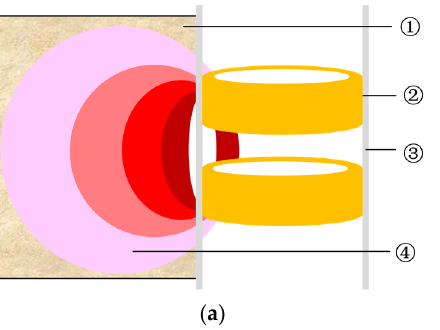
Figure 4. Structure and principle of high-frequency LC resonant capacitor probe. ( a ) Structural diagram; ( b ) circuit diagram. 1 (cid:13) Soil; 2 (cid:13) copper ring; 3 (cid:13) PVC pipe; 4 (cid:13) electromagnetic